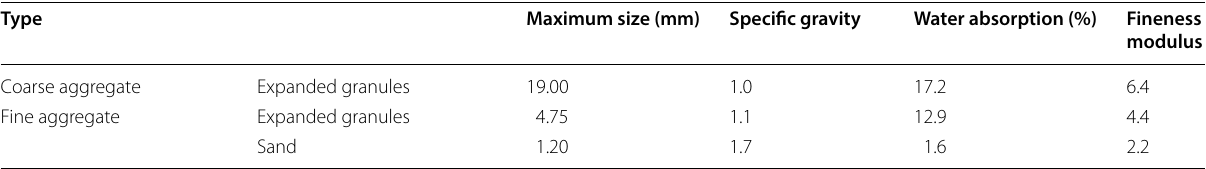
Table 1 Properties of the aggregates